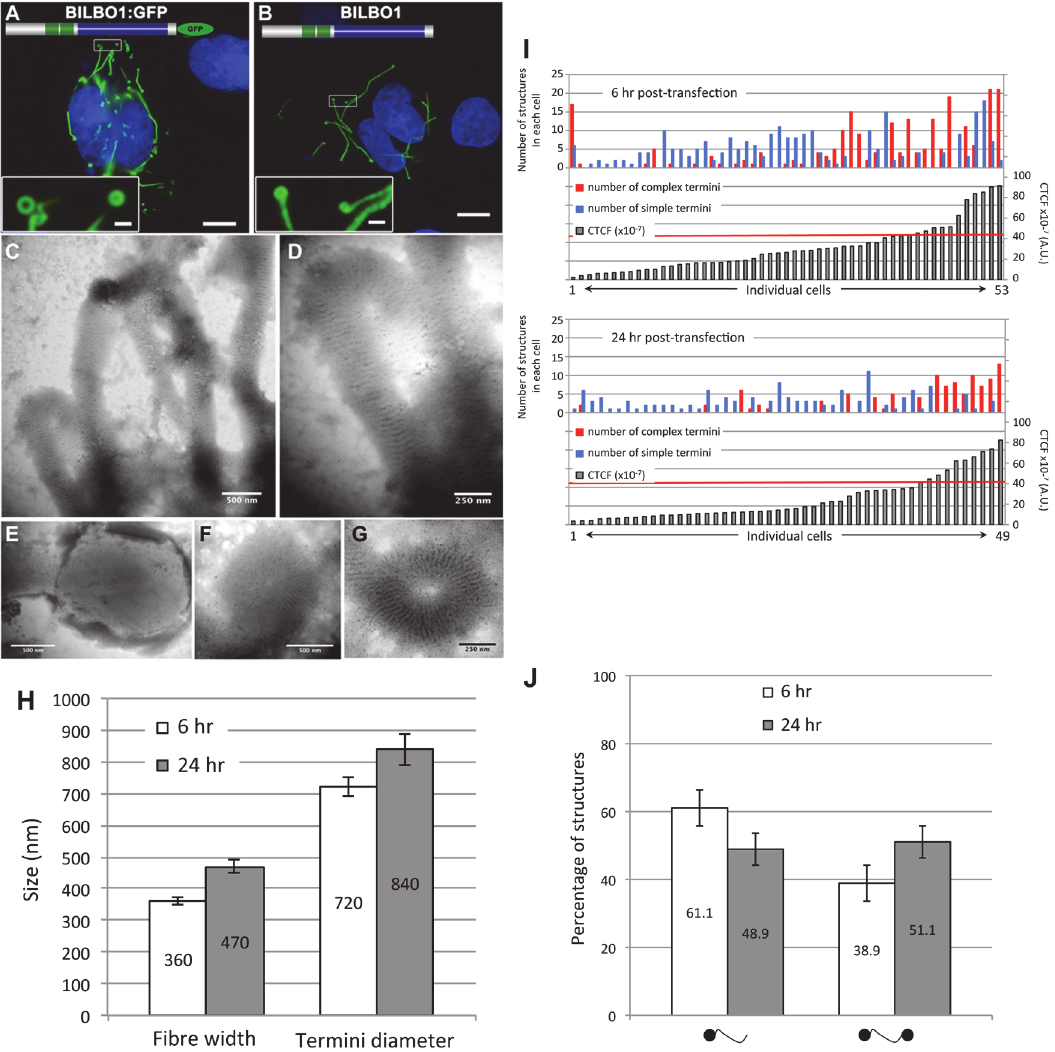
Fig 3. BILBO1 forms polymers in a heterologous system and the coiled-coil domain is required for polymerization. Heterologous expression of BILBO1:GFP (A), or un-tagged BILBO1 (B) in mammalian U-2 OS cells demonstrate that BILBO1 has self-polymerizing properties. After 6 hours post- transfection of BILBO1:GFP the polymers formed were observed by direct GFP fluorescence. After 6 hours post-transfection of un-tagged BILBO1, extracted cells were immuno-labelled with anti-BILBO1 monoclonal antibody. (C-F) Electron micrograph of extracted and negative stained U-2 OS cells after six hours of BILBO1 expression. (G) Electron micrograph of extracted and negative stained U-2 OS cells after six hours of BILBO1:GFP expression. (H) Measurements of fibre width and diameter of termini in U-2 OS cells expressing BILBO1 after six or 24 hours post-transfection and immunolabelled with anti- NTD. (I) Measurements of total fluorescence emitted per cell, as arbitrary units, after a fixed time of acquisition on anti-NTD immunolabelled BILBO1 expressing U-2 OS cells, and number of complex or simple termini in each corresponding cell. The red line indicates the 50% of maximum fluorescence intensity limit. (J) Determination of the percentage of complex polymers with termini at one end (left) or at both ends (right) in BILBO1 U-2 OS expressing cells after six or 24 hours transfection. Scale bars represent 10 μ m in A and B, 1 μ m in insets, 500 nm in C, E, F, and 250nm in D, G.